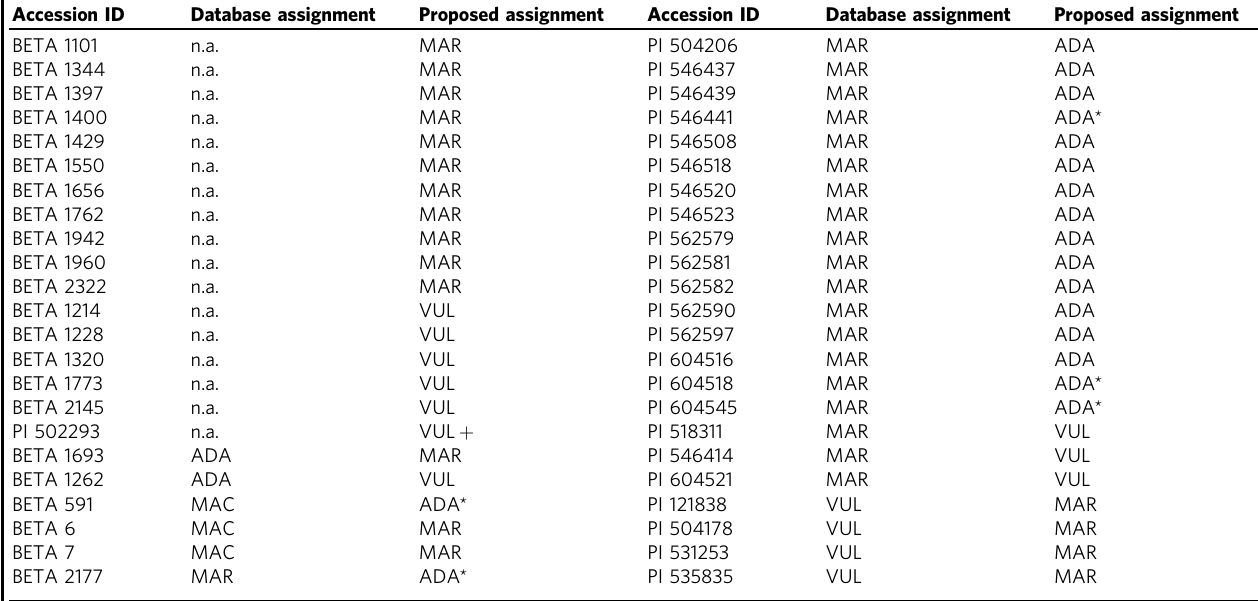
Table 2 Suggested taxonomic af fi liation of beet accessions based on phylogenetic